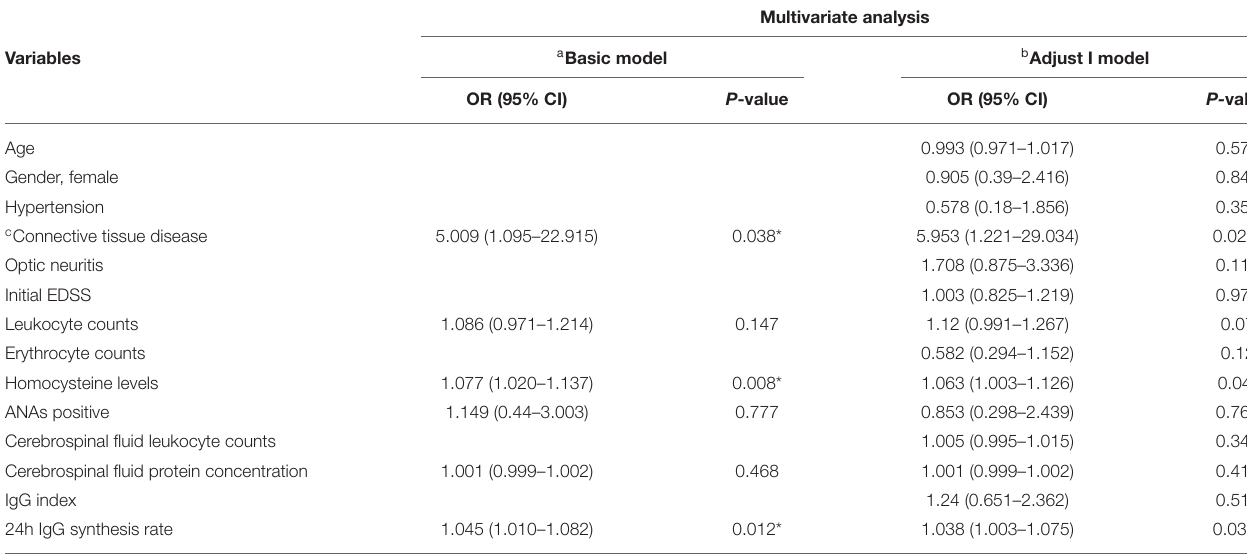
TABLE 4 | Multivariate logistic regression analysis of potential risk factors to predict high relapse events in patients with NMOSD.